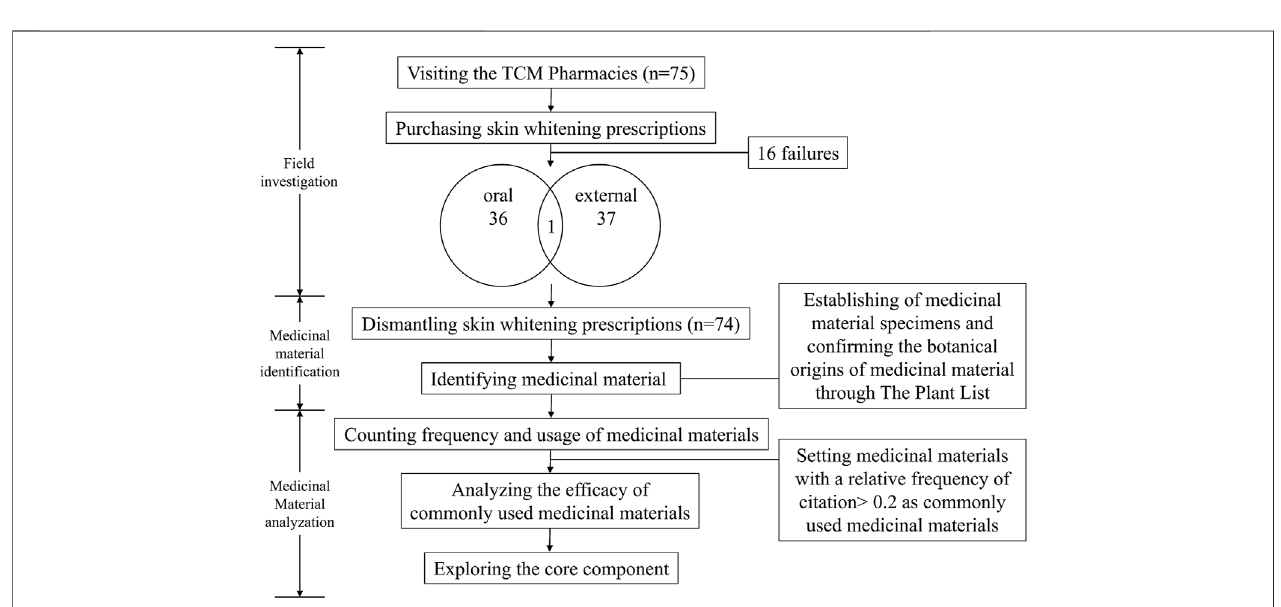
FIGURE 1 | Study fl